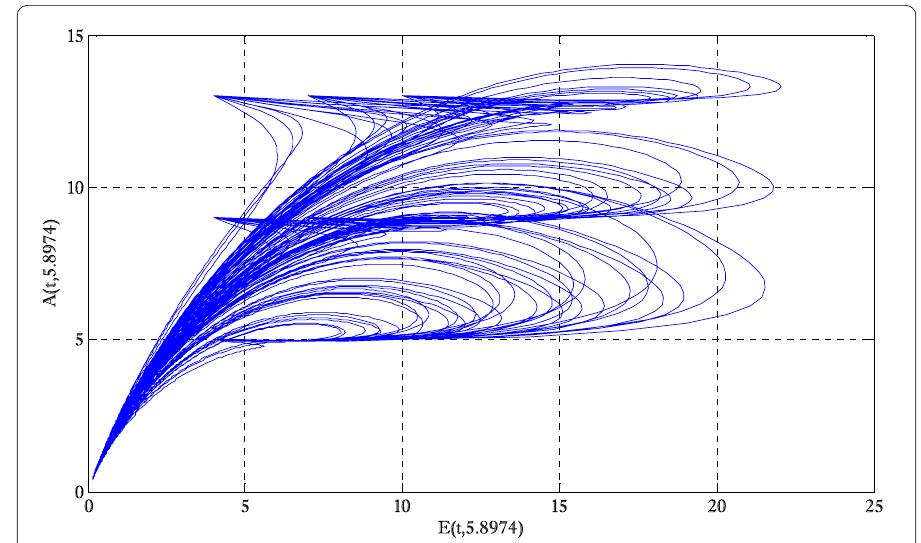
Figure 7 Two dimensional phase portrait of asymptomatic and exposed individuals